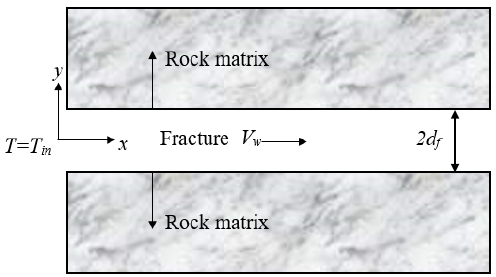
Figure 6. Schematic of 2D single-fracture model.